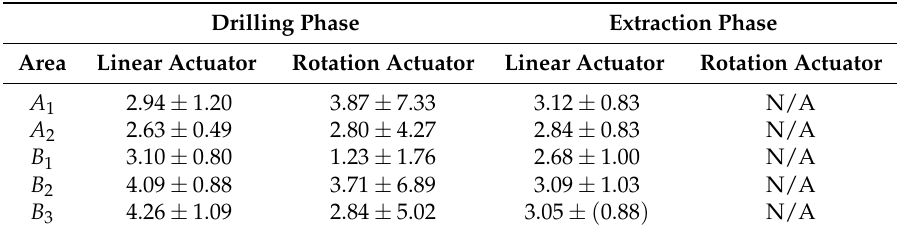
Figure 20. The ground vehicle during two sampling runs. ( a )–( d ) Sampling process in location B 2 , ( e )–( h ) Sampling process in location B 3 . Table 1. Average ± standard deviation of the current delivered to both the linear and rotation actuators of the sampling tool, over three sampling points. Each line of the table corresponds to a sampling area. All values are in amperes and have been obtained separately for the drilling and the extraction